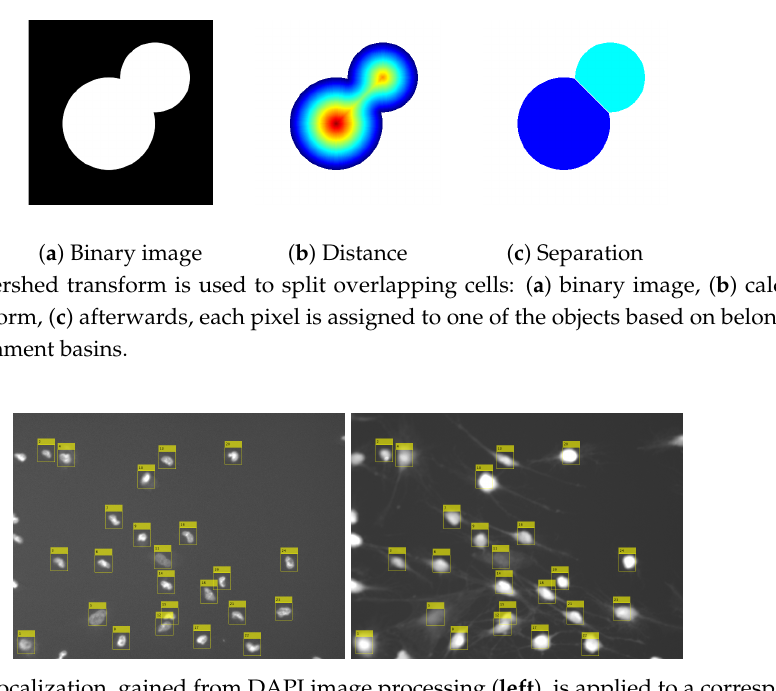
Figure 6. Cell localization, gained from DAPI image processing ( left ), is applied to a corresponding GFP image ( right ).